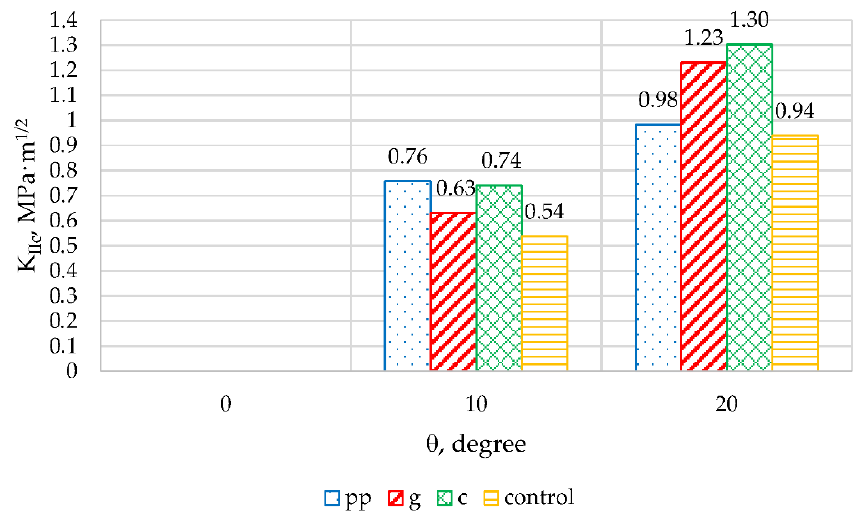
Figure 18. K IIC for all types of mortars for different crack inclination angles.